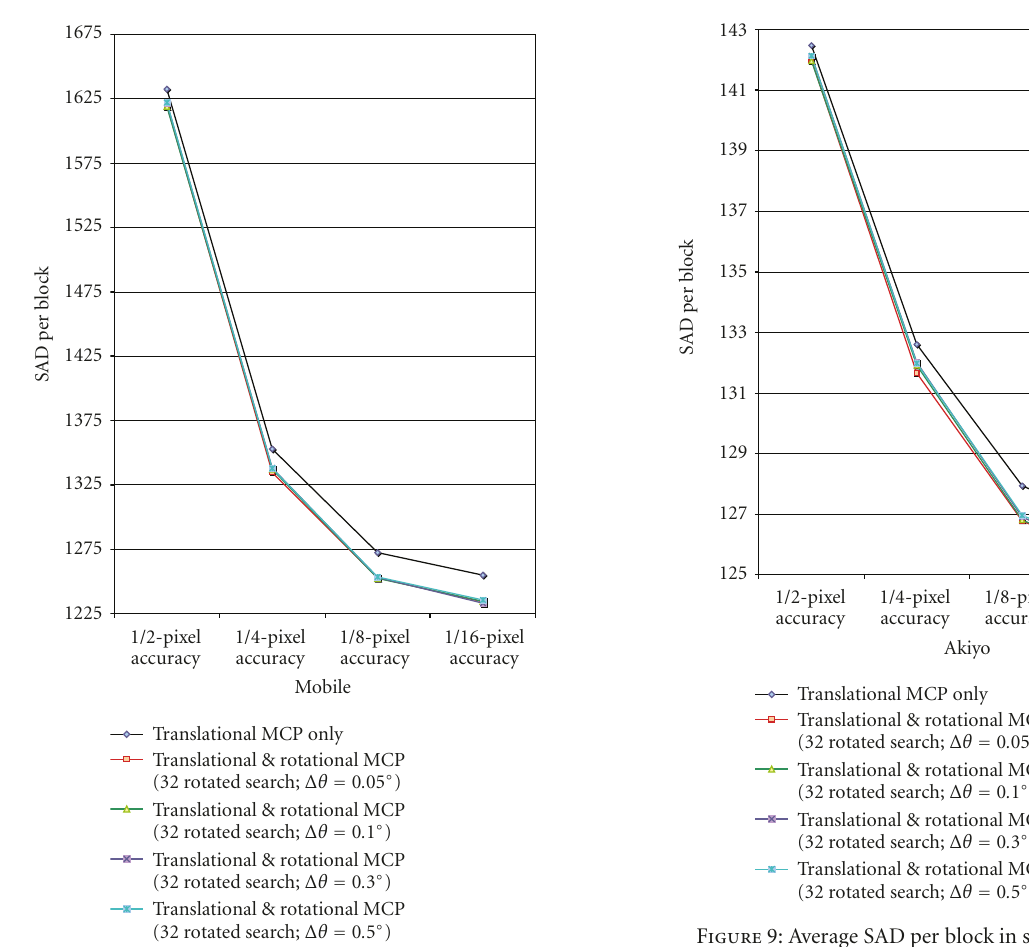
Figure 8: Average SAD per block in sequence Mobile .